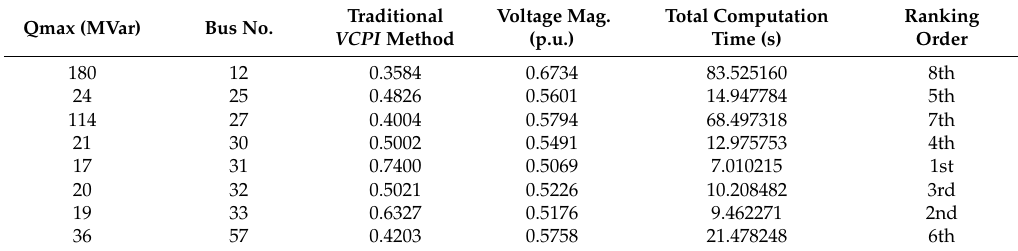
Table 9. Results of the VCPI for the IEEE 57-bus power system.